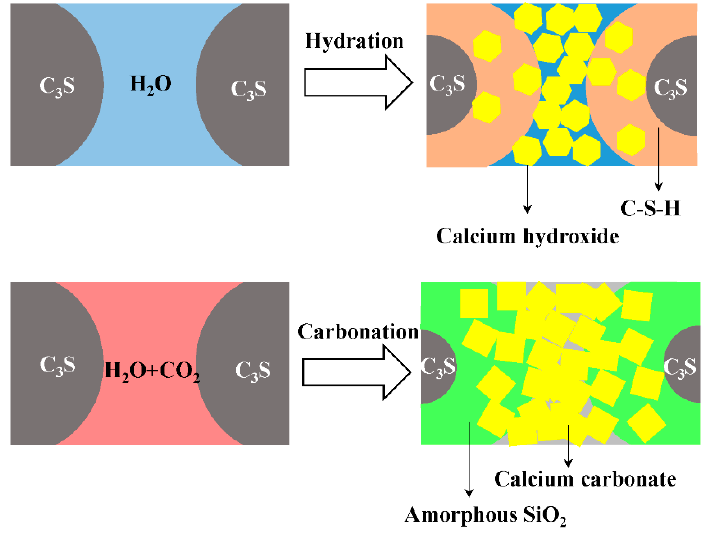
Figure 17. Schematic of the microstructure formation mechanism of C 3 S paste hydration and carbonation.